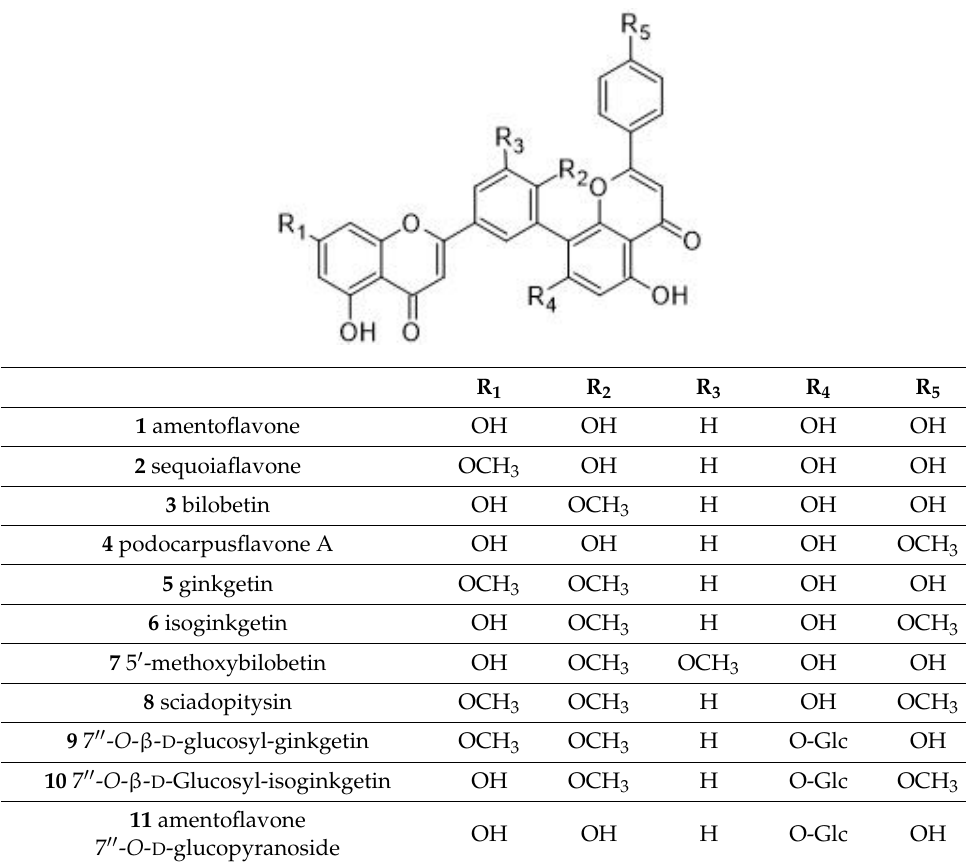
Table 1. Chemical structures of the flavone-flavone biflavonoids in ginkgo.